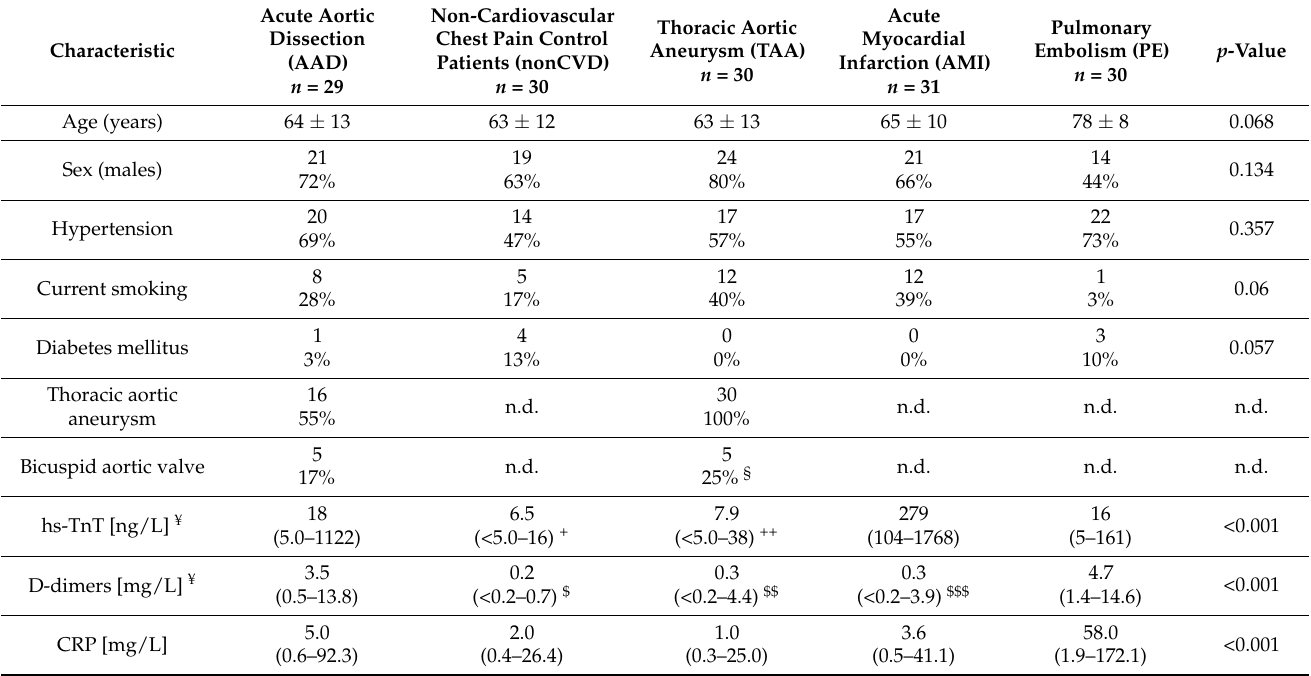
Table 1. Patients’ characteristics in the exploratory cohort.